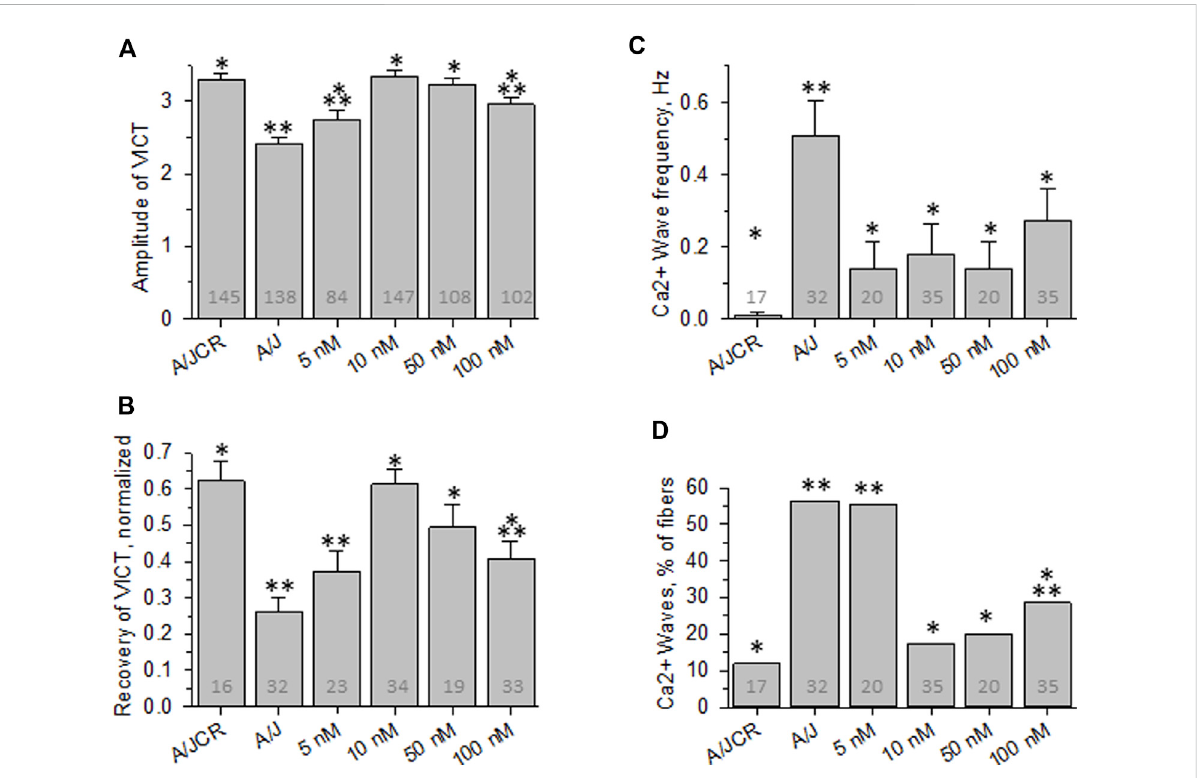
Effect of osmotic shock injury on Ca 2+ transients in FDB fi bers preloaded with different concentrations of BAPTA-AM. Data from experiments like those shown in Figure 1 were analyzed. (A) , averaged amplitudes of Ca 2+ transients before OSI presented as (F max -F 0 )/F 0 . (B) , averaged data for recovery of Ca 2+ transients at 5 min after OSI. (C) , averaged data for frequency of Ca 2+ waves at 5 min after OSI. (D) , % fi bers that produced Ca 2+ waves at 5 min after OSI. N is indicated in each bar. *. p < 0.05 compared to A/J (sham). **, p < 0.05 compared to A/JCr control. Student ’ s t test was used for A-C; Χ 2 was used for (D) . VICT = Voltage-induced Ca 2+